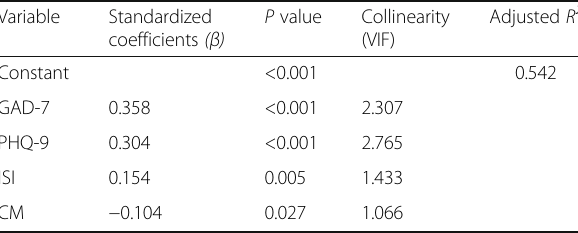
Table 4 Predictors for the PSS score in migraine patients by multivariate